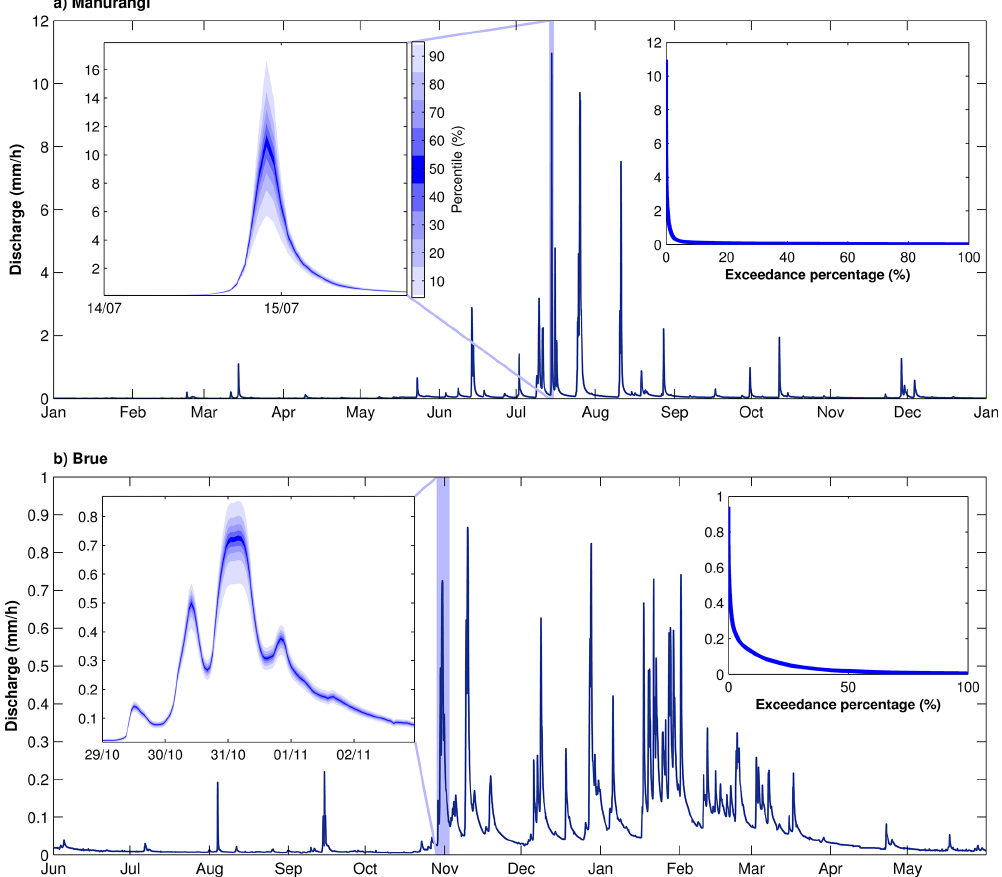
Figure 7. Discharge calculated using the optimal rating curve for 1998 for Mahurangi (a) and for 1994–1995 for Brue (b) . The left inset plots show the discharge time series uncertainty distribution at an hourly scale for a peak-flow event in each catchment. The right inset plots show the flow duration curves for the full time series for each catchment. The y axis variable and unit is discharge (in mmh − 1 ) in all plots.